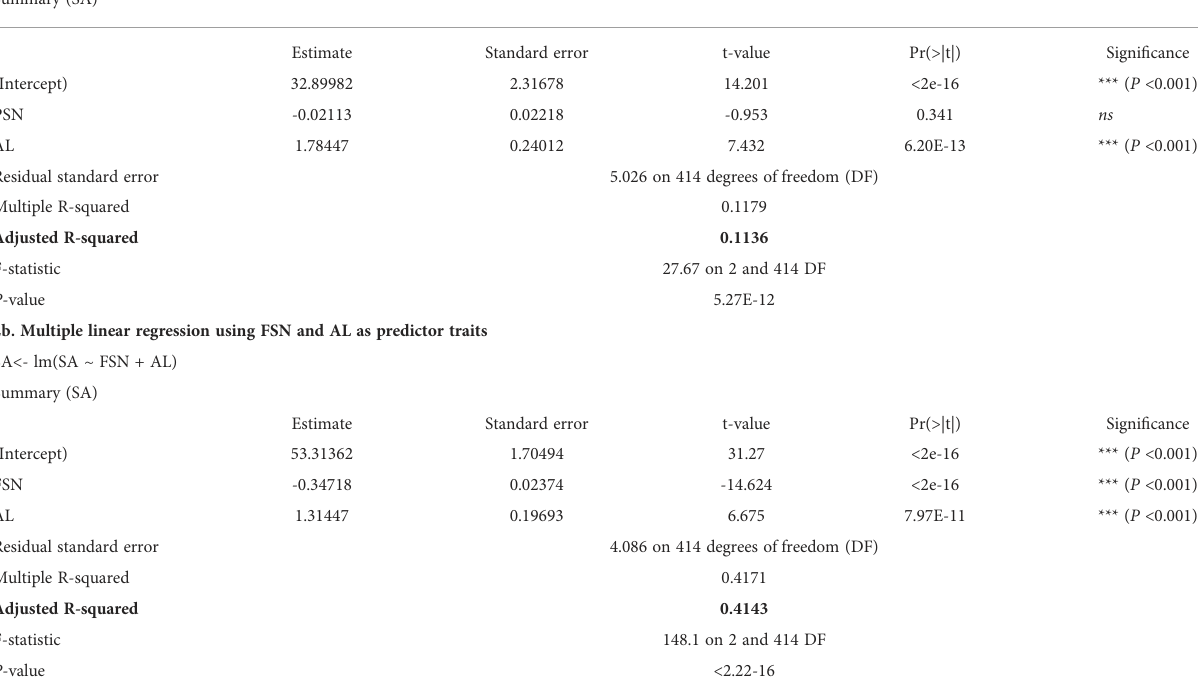
TABLE 2 Multiple linear regression for spikelet abortion (SA) using potential spikelet number (PSN), fi nal spikelet number (FSN) and awn length (AL) as predictor traits. 2a. Multiple linear regression using PSN and AL as predictor